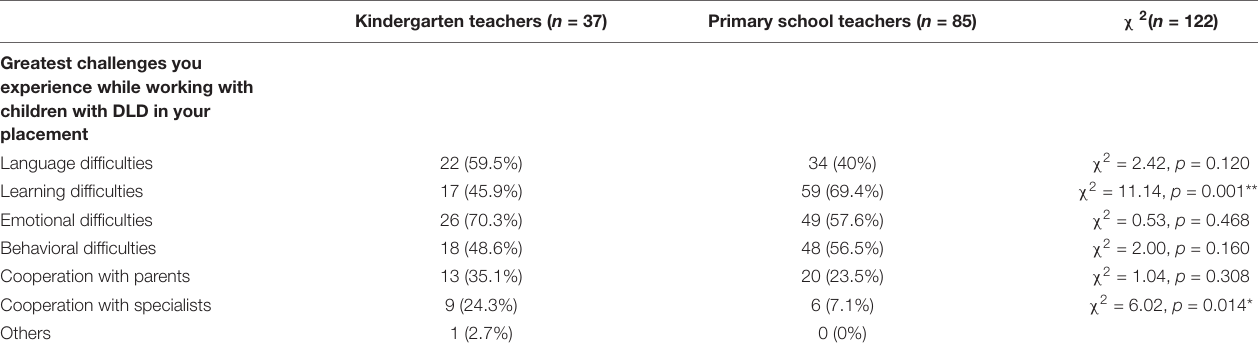
TABLE 4 | Mean (SDs) of teachers’ reported challenges ( 1 = strongly disagree, 2 = agree, 3 = disagree, 4 = strongly disagree 5 = strongly agree